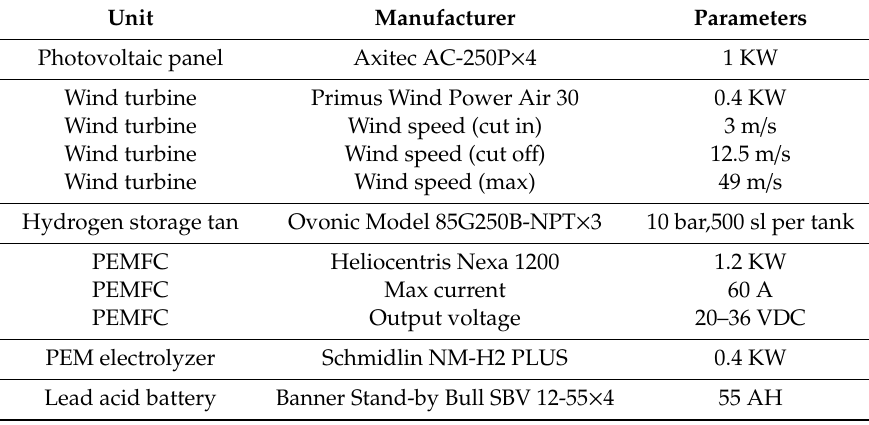
Table 1. Capacity configurations of multi-energy complementary